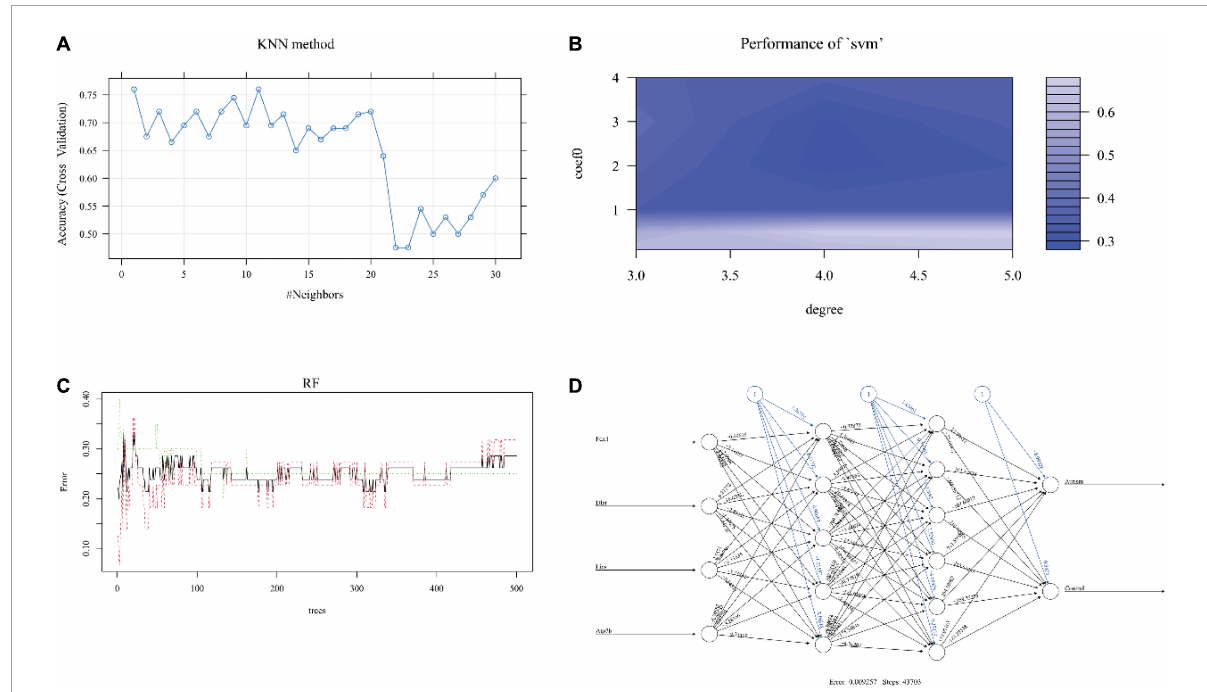
FIGURE4 The performance of each machine learning model. The relation between the number of neighbors (k value) and accuracy in KNN (A) . The degree and coefficient of SVM are shown in panel (B) . In RF, the interrelation between the number of trees and model error is shown in panel (C) . After 43,703 steps, the error was 0.009257 in the ANN model (D) . KNN, k-nearest neighbor; SVM, support vector machine; RF, random forest; ANN, artificial neural